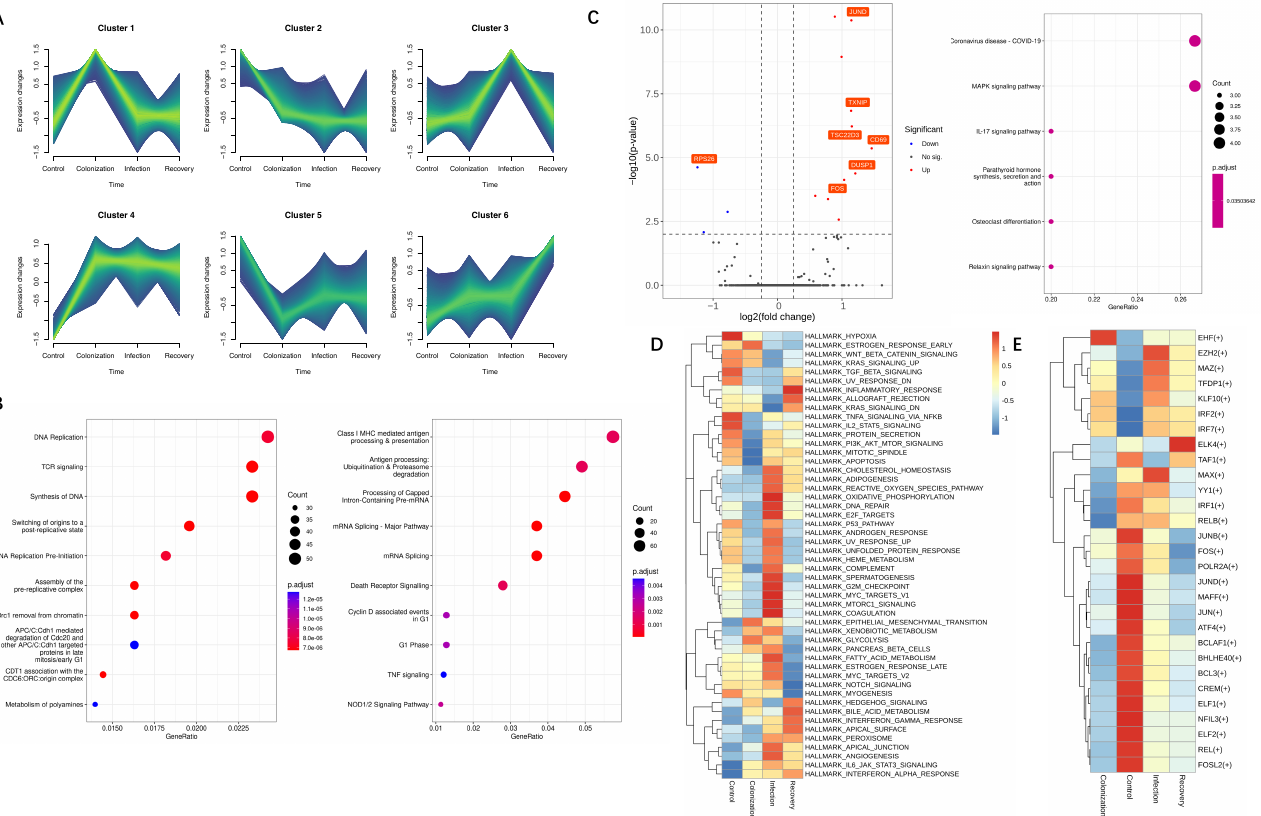
Figure 3. The function changes on NKT subsets during CRKP infection. ( A ) Genes contained in NKT clustered by their expression pattern along the progression of the disease by the mfuzz R package. The top 10 enriched biological processes in cluster 4 ( left ) and cluster 5 ( right ) of genes revealed by Reactome analysis. ( B ) Gene expression heatmap in each cell cluster of myeloid-cell subsets as defined in ( A ). ( C ) The left figure showed differentially expressed genes in the CD56hiNKT cluster from CRKP infection patients compared to healthy controls. Red dots represent genes upregulated in CRKP infection patients (adjusted p value < 0.01 and fold change (FC) ≥ 2), whereas blue dots represent downregulated genes in CRKP infection patients (adjusted p value < 0.01 and FC ≤ 0.5). Genes with log2(FC) ≥ 1.5 were labeled by gene symbols. The right figure shows enriched pathways of defined genes by KEGG analysis. ( D ) GSVA analysis indicating the enriched Molecular Signatures Database hallmark gene sets of the NKT cluster across conditions. ( E ) TF analysis indicating the predicted regulators of the NKT cluster across